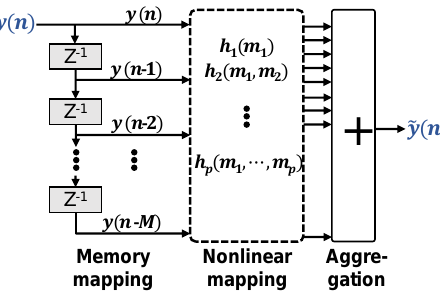
Figure 1. General nonlinear volterra equalizer.